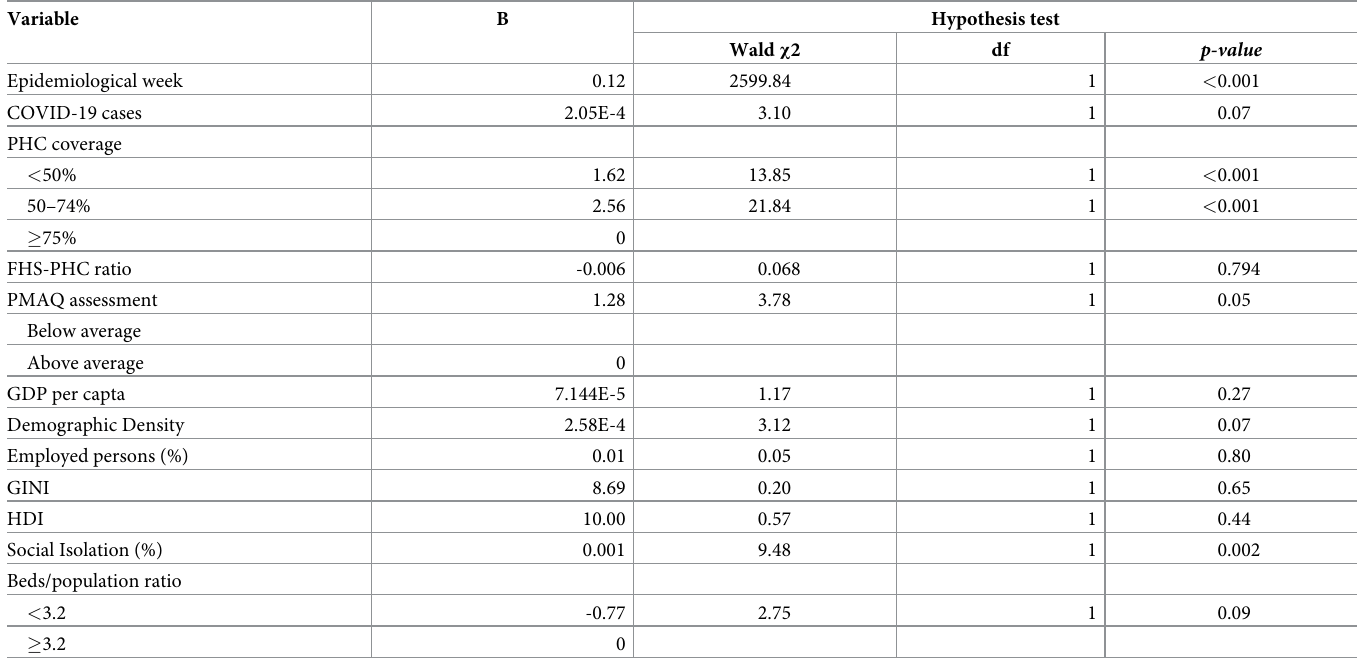
Table 3. Crude model for association with COVID-19 deaths in the time-series of twenty epidemiological weeks in Northeastern cities in